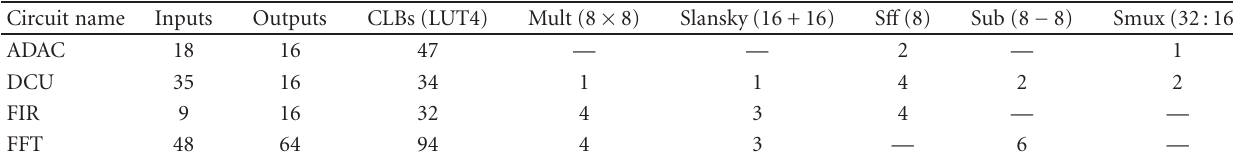
Table 1: DSP benchmarks set I.